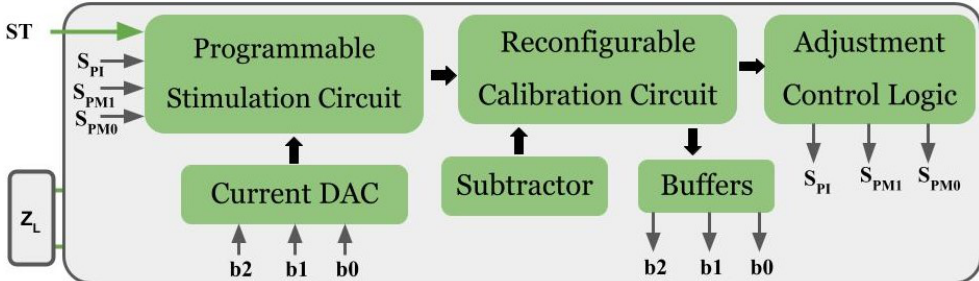
Figure 1. Proposed architecture.